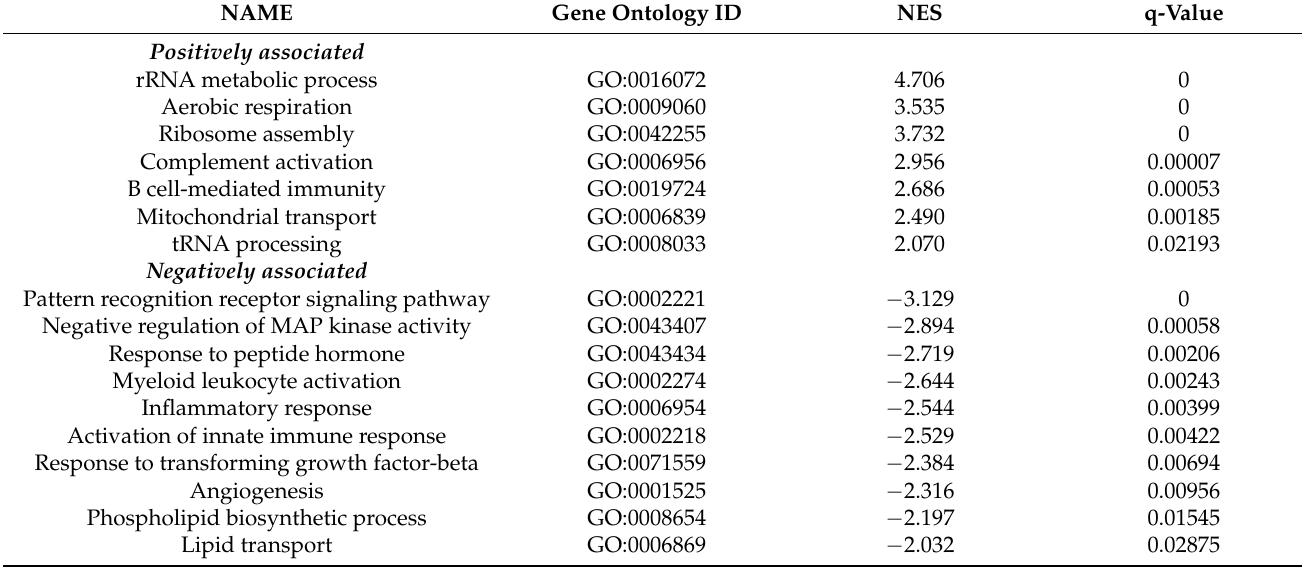
Table 2. Top non-redundant Gene Ontology biological processes associated with